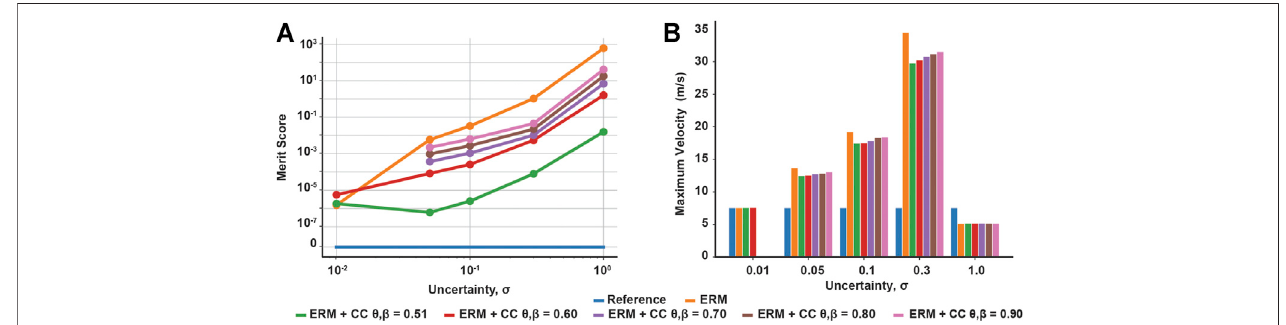
FIGURE 3 | Chance constraint mediated trade-off between expected friction cone feasibility and robustness to friction uncertainty (signi fi ed by maximum sliding velocity). (A) Merit scores across uncertainty and risk tolerances, quantifying violation of the expected friction cone constraint. (B) Maximum sliding velocity across uncertainty and risk tolerances, signifying robustness as larger velocities indicate shorter sliding times. Both constraint violation and maximum velocity increase with increasing uncertainty and with increasing risk bounds. Missing data points indicate the optimization was not solved successfully.